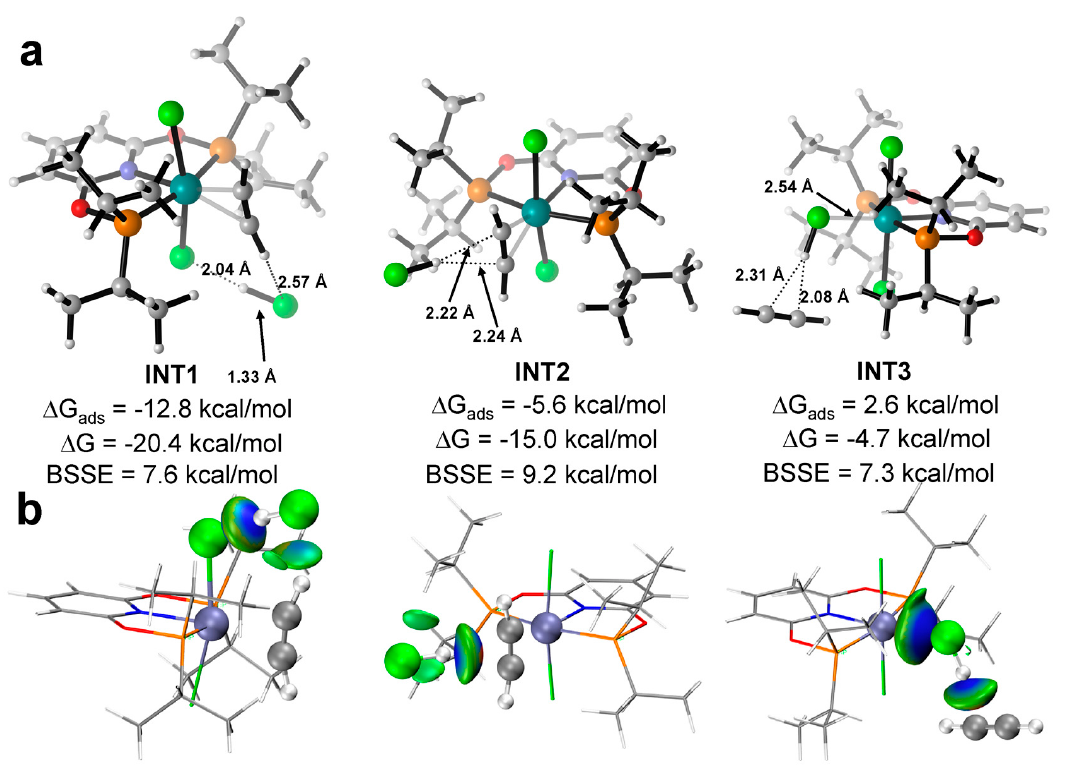
Figure 3. ( a ) The optimized structure of the co-adsorption state as INT1 , INT2 and INT3 with the key bond length (black numbers); ( b ) The IGM analysis of INT1 , INT2 and INT3 . Ball colors: green (Cl), gray (C), white (H), blue (N), red (O), brown (P), cyan (Ru).